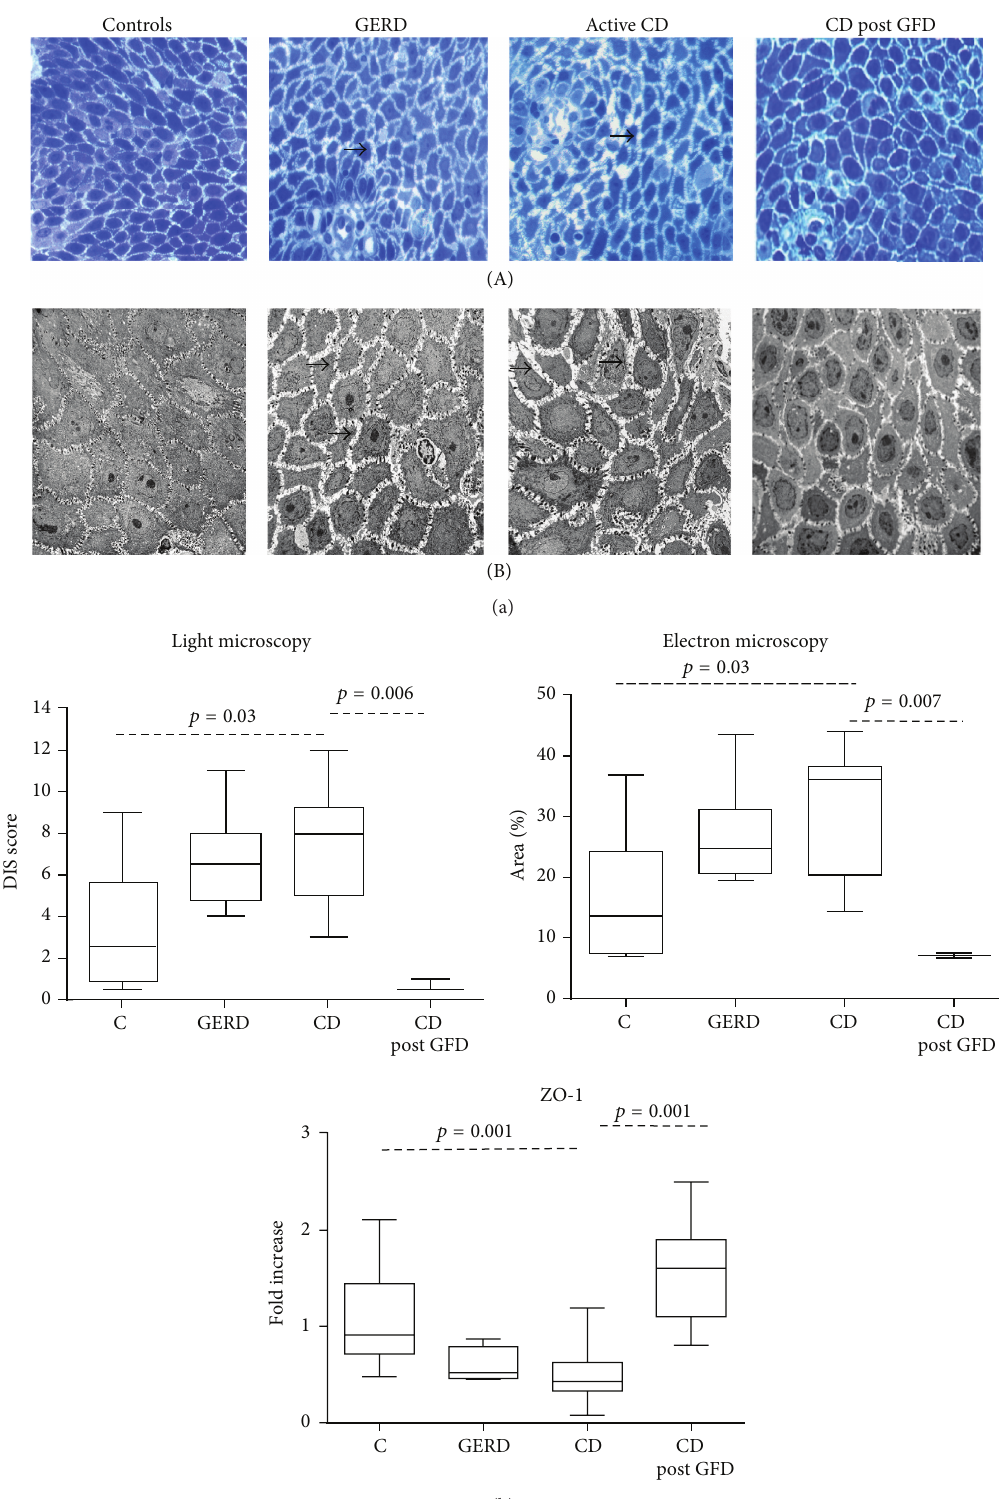
Figure 1: (a) Examples of intracellular spaces in the esophageal mucosa of controls (C), GERD patient, active CD patient before gluten free diet (CD), and CD patient after one year of gluten-free diet (CD post GFD) assessed by light microscopy (A) and electron microscopy (B). Black arrows indicate dilated intracellular spaces (DIS). (b) Group DIS scores assessed by light microscopy, electron microscopy, and mRNA expression for zonula occludens-1